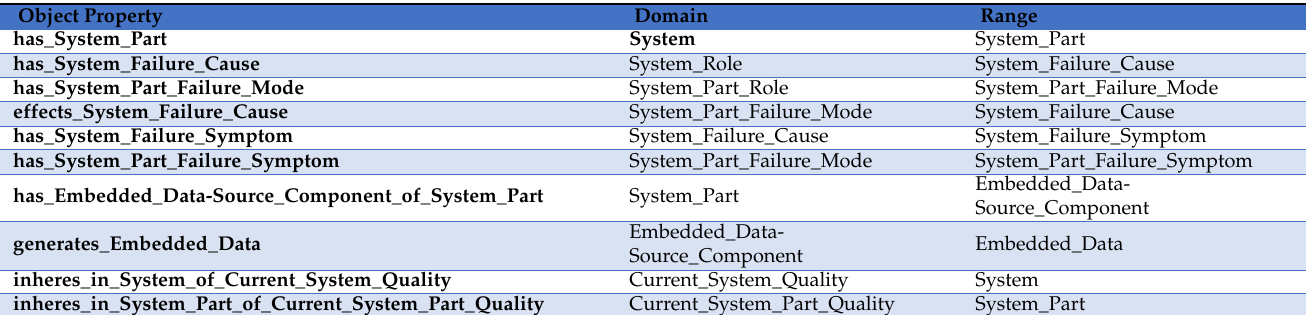
Table A3. Z-BRE4K Ontology Object